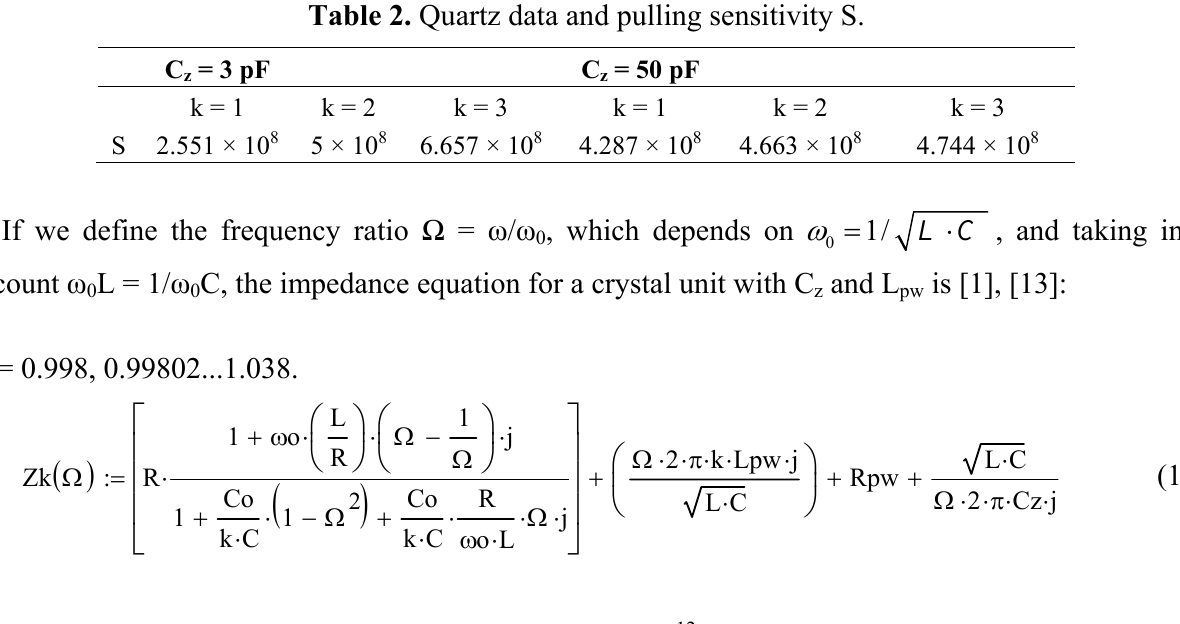
Figure 4. Compensated quartz impedance (C